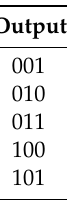
Table 4. Relationship between output and leaf cluster.